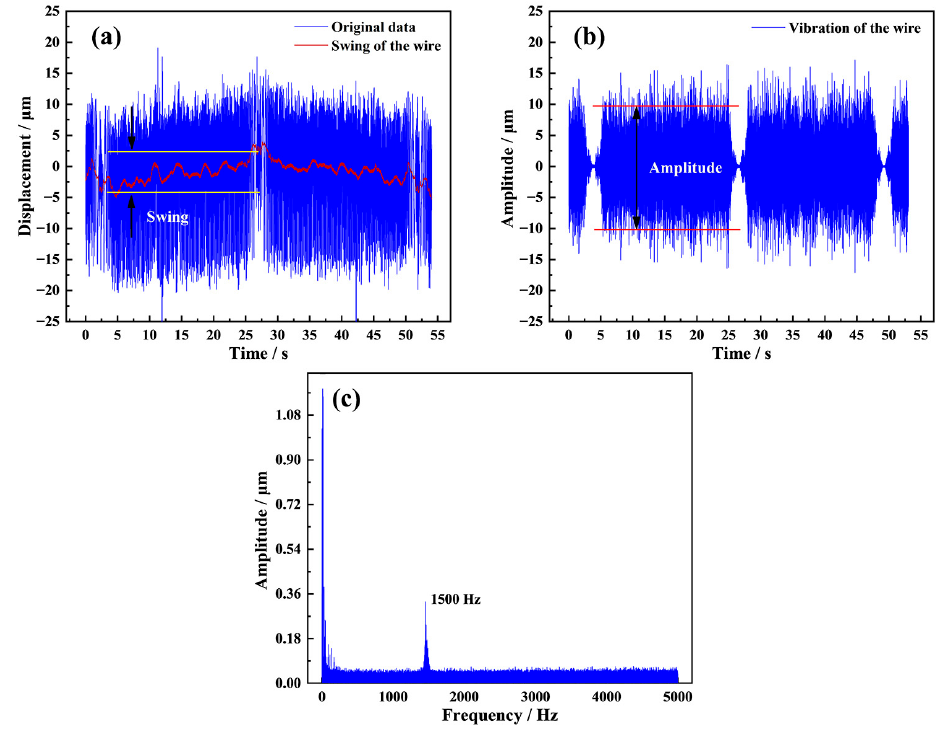
Figure 5. ( a ) Lateral displacement of the diamond wire in one reciprocating cycle; ( b ) the vibration of the diamond wire in one reciprocating cycle; ( c ) the frequency–amplitude characteristics of the wire vibration.